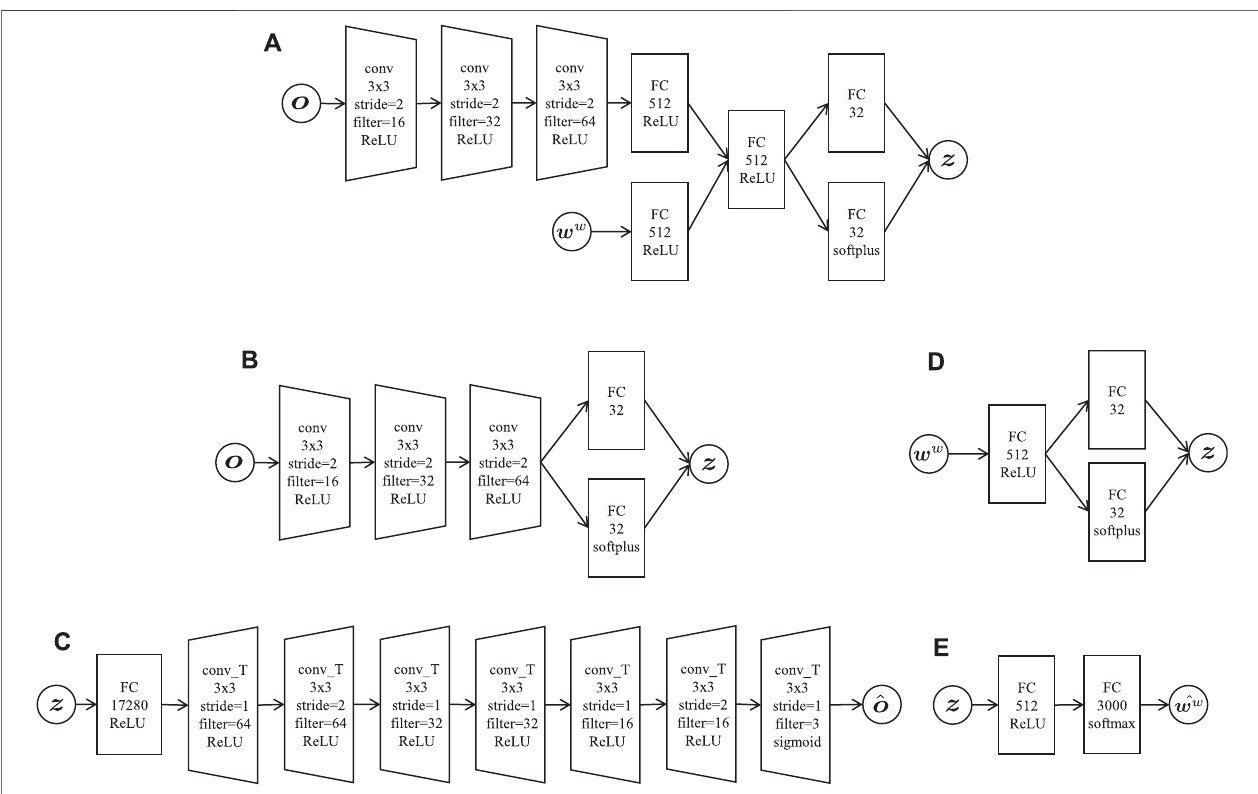
FIGURE12| NetworkstructureofJMVAEusedinexperiment: (A) jointencoder, (B) imageencoder, (C) imagedecoder, (D) wordencoder,and (E) worddecoder.